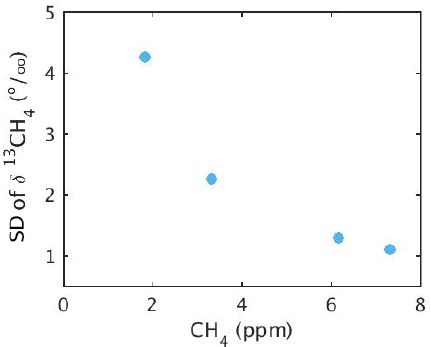
Figure 4. Standard deviation (SD) of the CH 4 isotopic ratio during the test results shown in Fig.